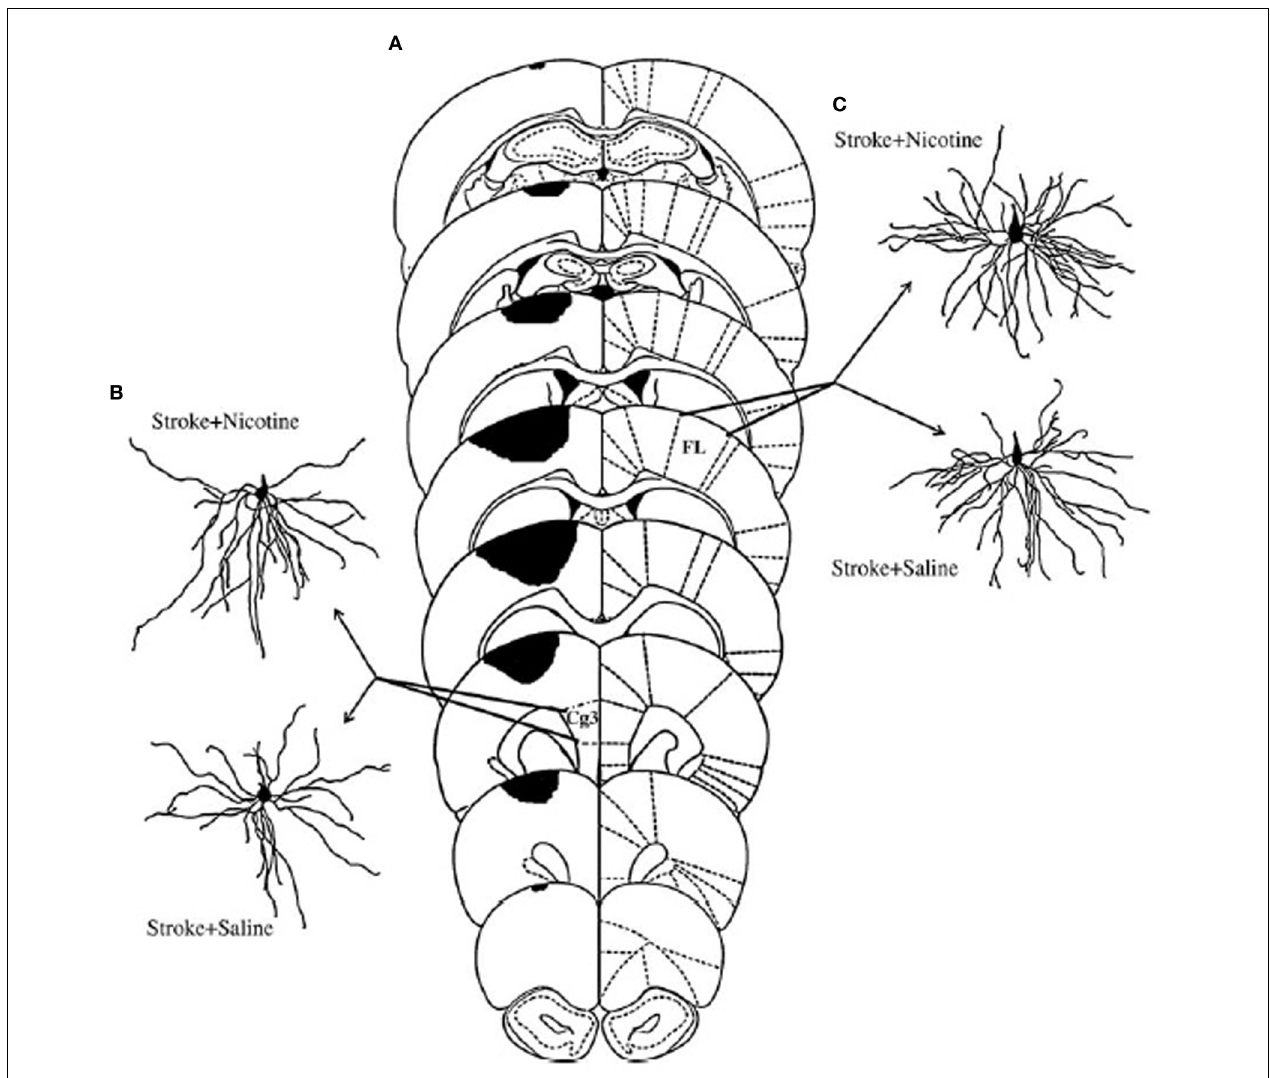
FIGURE 4 | (A) Extent of ischemic injury across 8 planes of measurement. (C) IllustraterepresentativecameralucidadrawingsoflayerVpyramidalneuronsin anterior cingulate cortex (Cg3) ipsilateral to the lesion (B) , or forelimb area (FL)